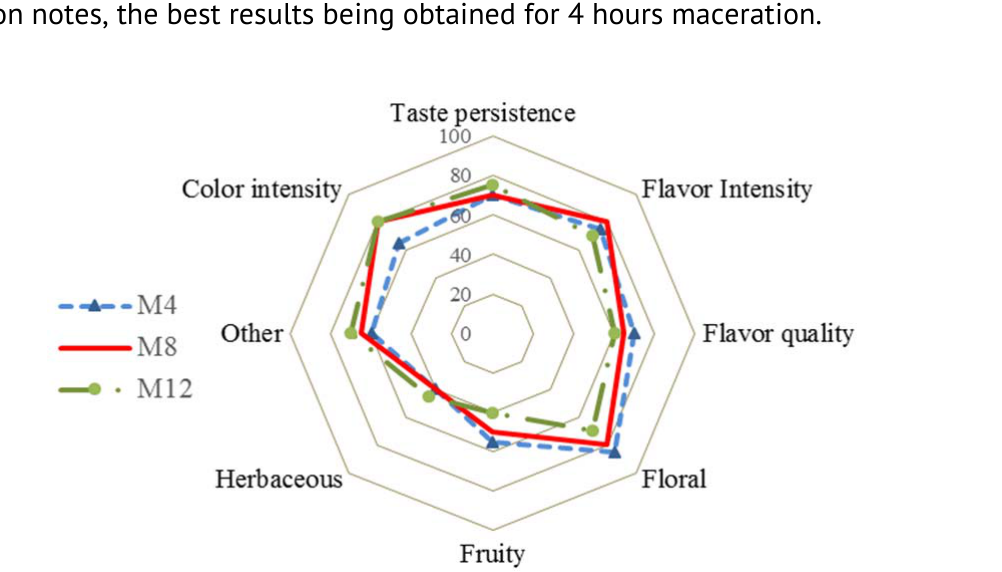
Figure 2. Sensory analysis of Viorica wines obtained through different maceration time (M4 – 4 hours; M8 – 8 hours; M12 – 12 hours) at the temperature of 15 o